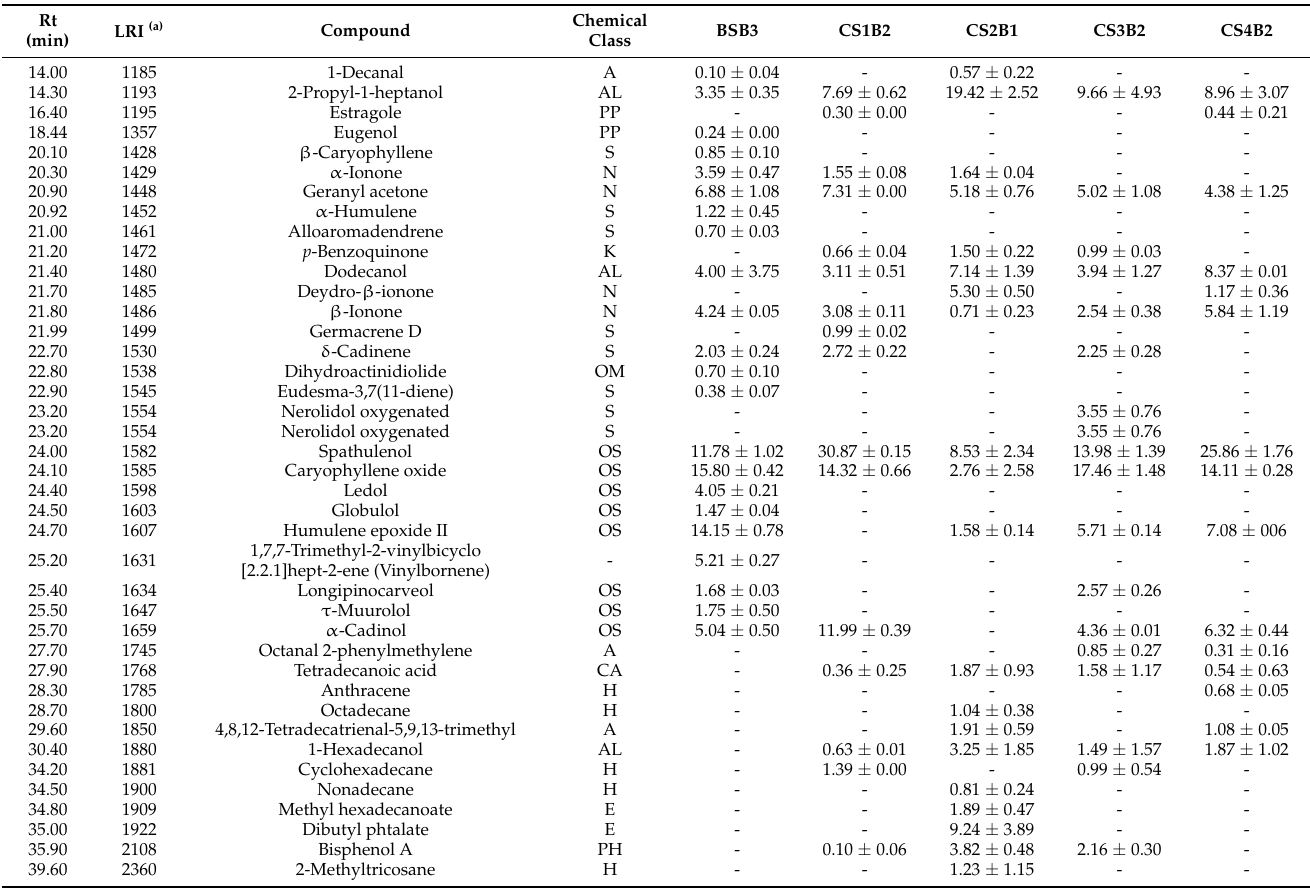
Table 3. Tentatively identified compounds of B. forficata infusions with their respective relative percentage